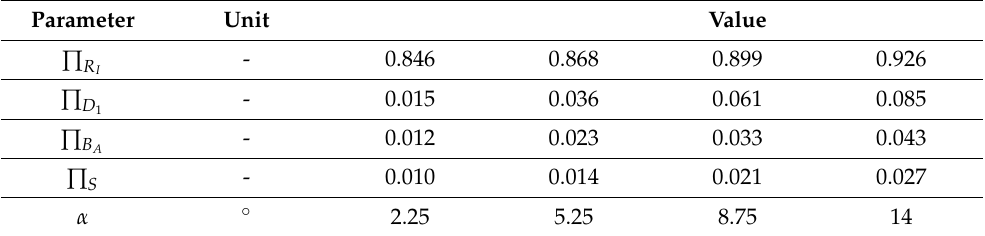
Table 6. Geometry parameter ranges for the validation dataset. Parameter